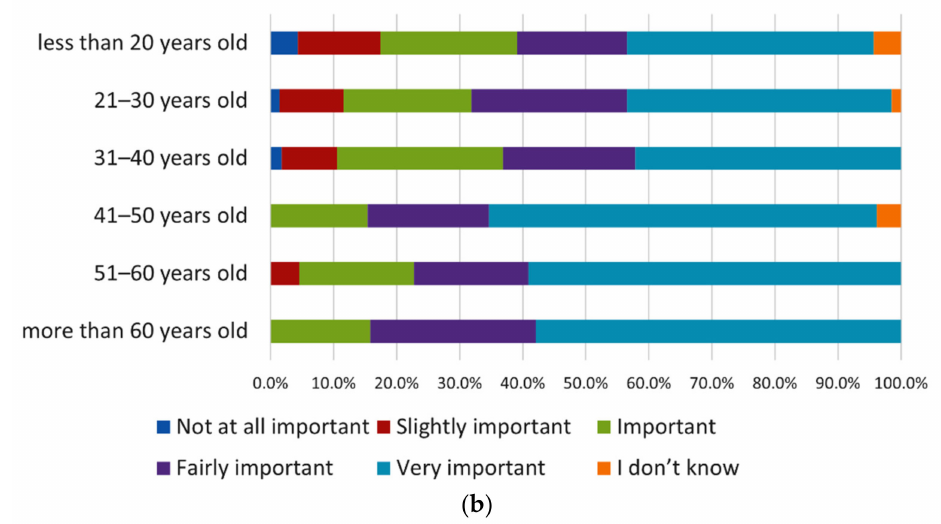
Figure 6. Importance of UGS for ( a ) mental health and well-being ( n = 216) and ( b ) physical health and well-being ( n = 216) according to subjective views of different age groups.